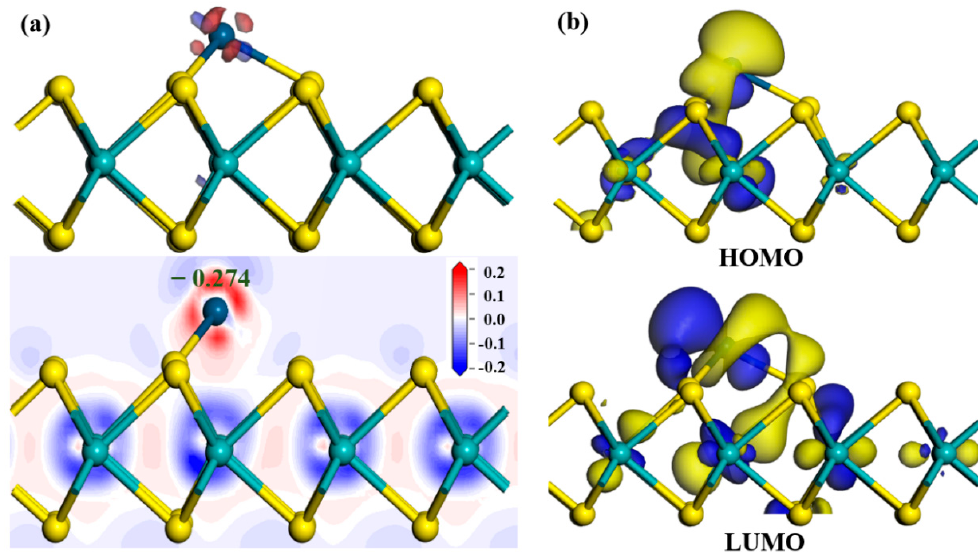
Figure 3. The ( a ) DCD, ( b ) HOMO, and LUMO distributions of Ir-modified MoS 2 system.